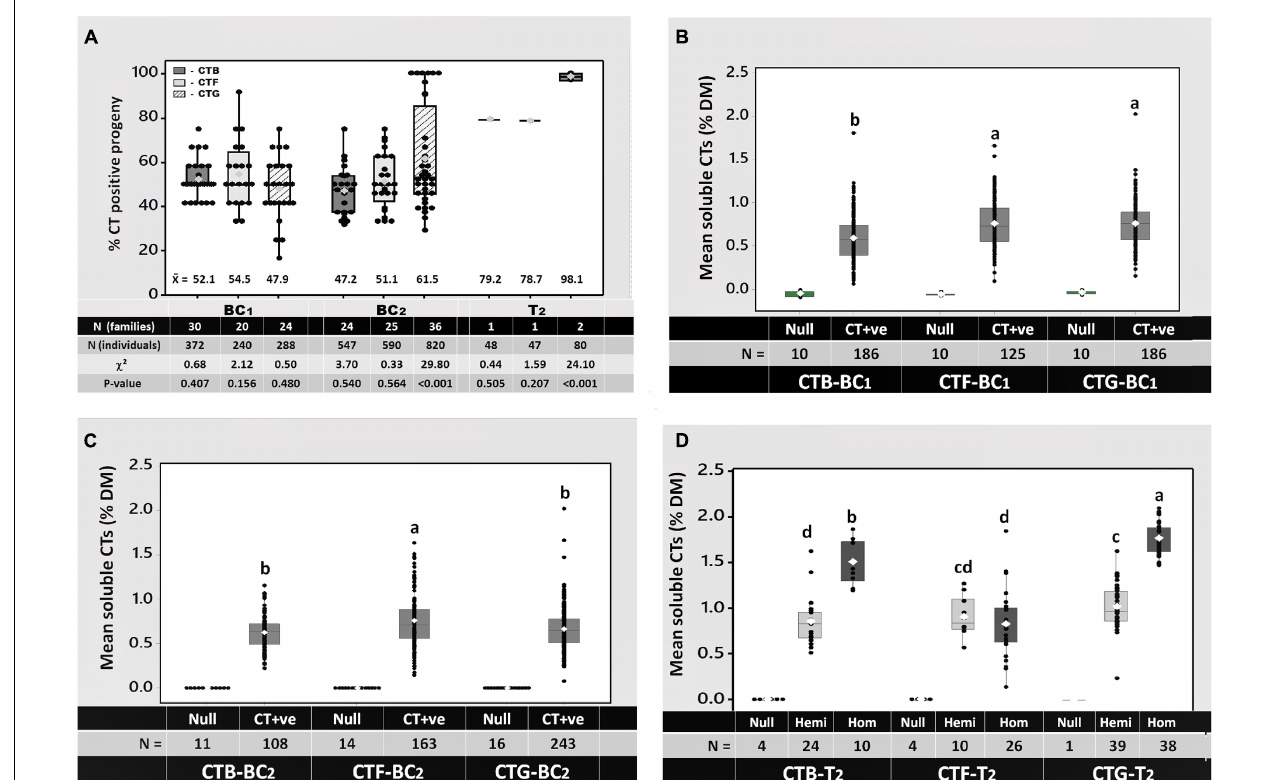
FIGURE 3 | (A) Segregation of the condensed tannin leaf trait in the first (BC 1 ) and second (BC 2 and T 2 ) generations of CTB, CTF, and CTG progenies, and (B–D) quantitation of soluble condensed tannins in the leaves of (B) backcross 1 (BC 1 ), (C) backcross 2 (BC 2 ), and (D) T 2 (BC 1 x BC 1 ) progenies. In panel (A) , the mean of each group is written below each bar. The number of families and individuals analyzed, as well as chi-square statistics for each group of progenies and corresponding P -values, is also provided at the bottom of panel (A) . In panels (B–D) , each data point shows the mean soluble CTs in the leaves of an individual plant at 8 and 12 weeks after planting, expressed in percent dry matter (% DM, epigallocatechin equivalents). The white diamonds in panels (B–D) show the group mean CTs as a percent of DM; different letters on top of bars indicate significant mean differences in each group by Tukey’s Multiple Comparison Test (MCT) P ≤ 0.01. The total number (N) of individuals analyzed per group is provided below each bar. In panel (D) , the null, hemi (hemizygotes), and the hom (homozygotes) are individuals that contain 0, 1, and 2 copies of the TaMYB14-1 gene, respectively.